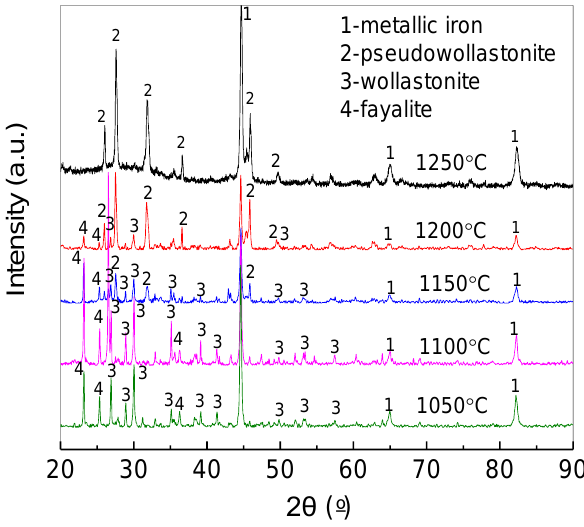
Figure 7. XRD patterns of roasted products obtained at different roasting temperatures.